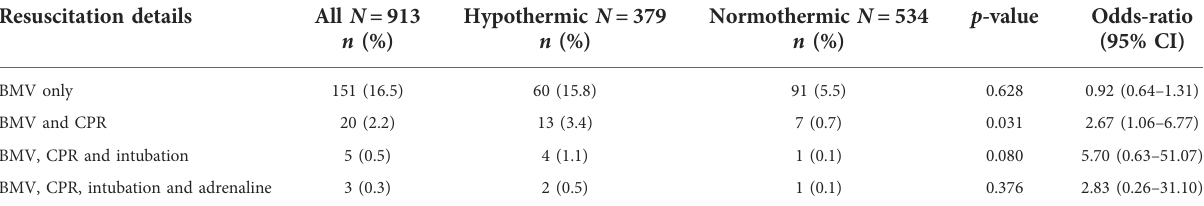
TABLE 4 Resuscitative measures undertaken.